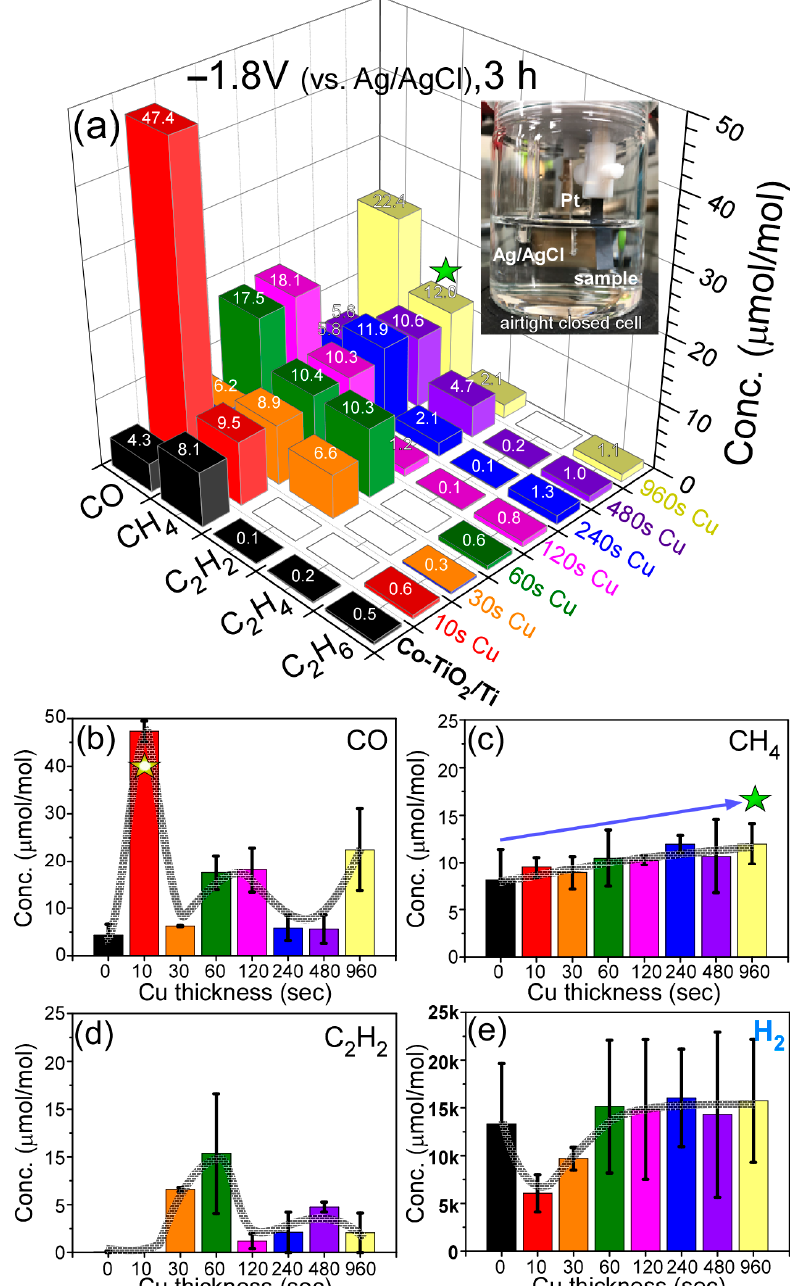
Figure 8. Electrocatalytic CO 2 reduction product yields ( a ) for bare Co-TiO 2 /Ti and 10s, 30 s, 60 s, 120 s, 240 s, 480 s and 960 s-Cu-deposited Co-TiO 2 /Ti samples, and CO ( b ), CH 4 ( c ), C 2 H 2 ( d ) and H 2 ( e ) yields ( μ mol/mol) with error bars. Photo is the electrochemical 3-electrode air-tight closed cell. The asterisk indicates the maximum point for CH 4